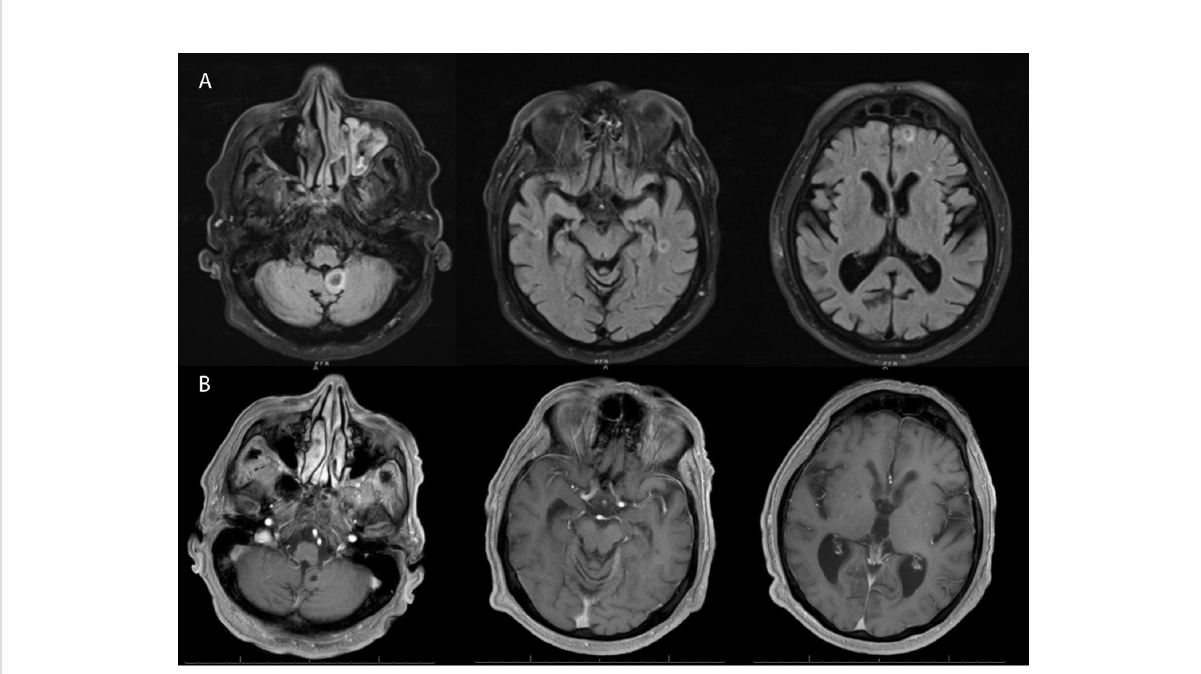
FIGURE 3 (A) Magnetic resonance imaging (axial section) of brain at recurrence showing numerous non-enhancing lesions (only showing index lesions) in the supratentorial and infratentorial brain with susceptibility artifact and subtle restricted diffusion of the margins and T2 hyperintense signals surrounding them, with the largest lesion in the left cerebellar vermis (14x12mm). (B) Follow up MRI after 4 months showing resolution of the non-enhancing lesions and only a small foci of low signal intensity noted within the posterior fossa representing chronic